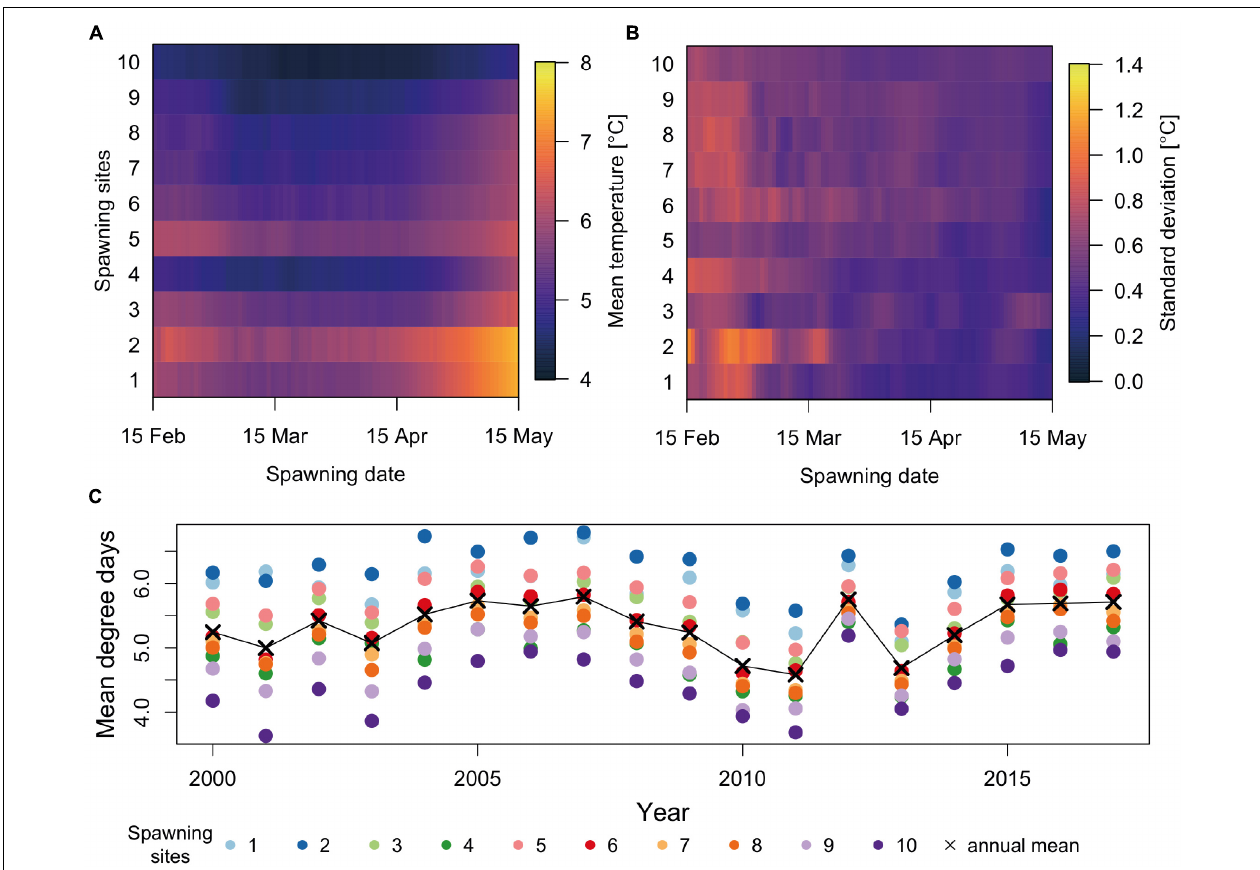
FIGURE 2 | (A) Mean modeled ambient temperature of eggs until hatching from 2000 to 2017 by spawning site and spawning date. (B) Corresponding standard deviation for between-year variation of temperature. (C) Time series of annual mean ambient temperatures until hatching from 2000 to 2017 (black line connecting x’s) along with the annual mean ambient spawning site specific temperatures (colored